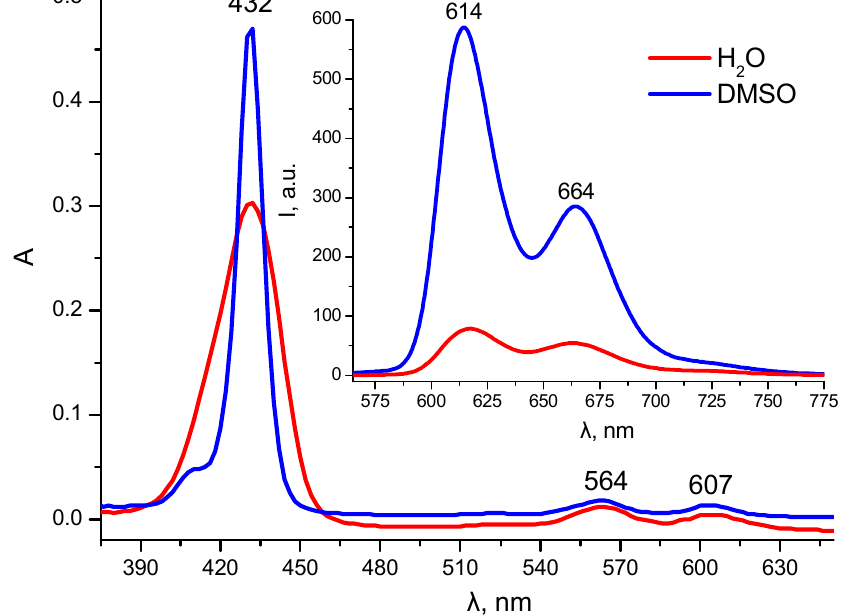
Figure 2. UV–Vis absorption and fluorescence (insert) spectra of 7 (C = 1.15 µ M) in DMSO and H 2 O ( λ ex = 432 nm).